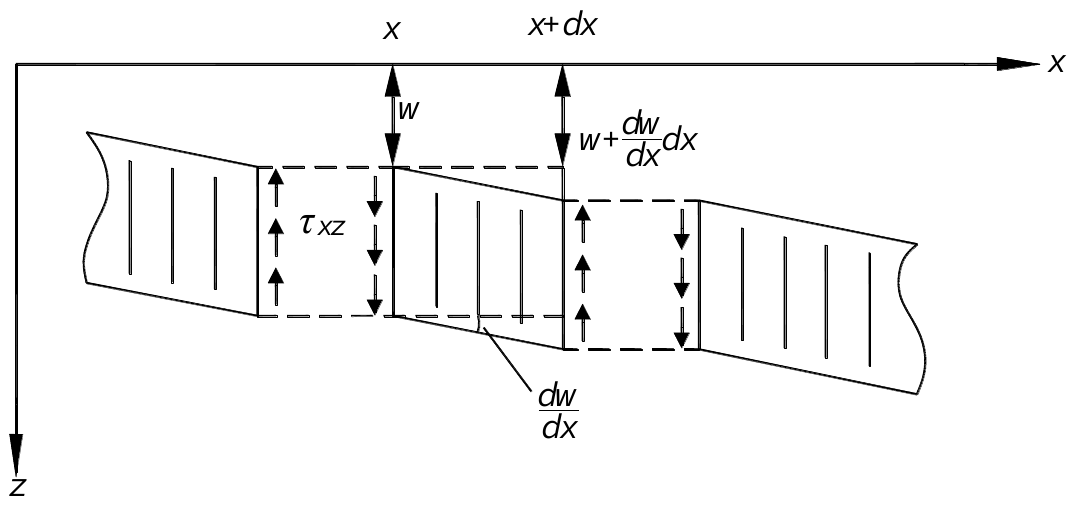
Figure 4. An element of shear layer in Pasternak foundation.